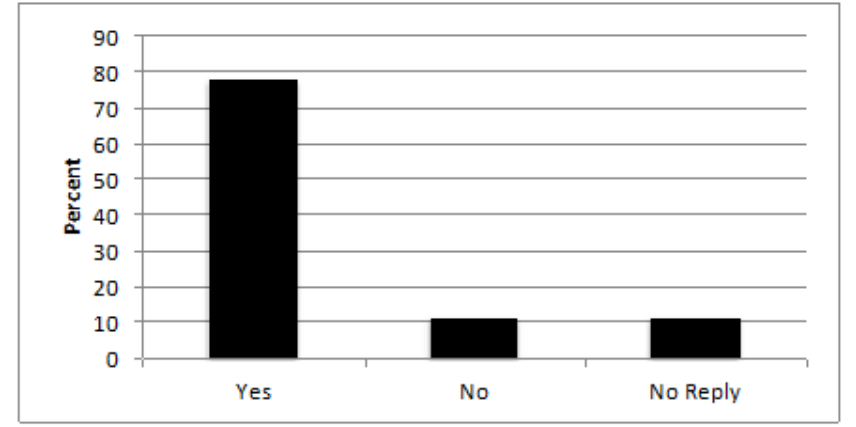
Figure 16. Responses to see if the students understood the topic better than before the experimental